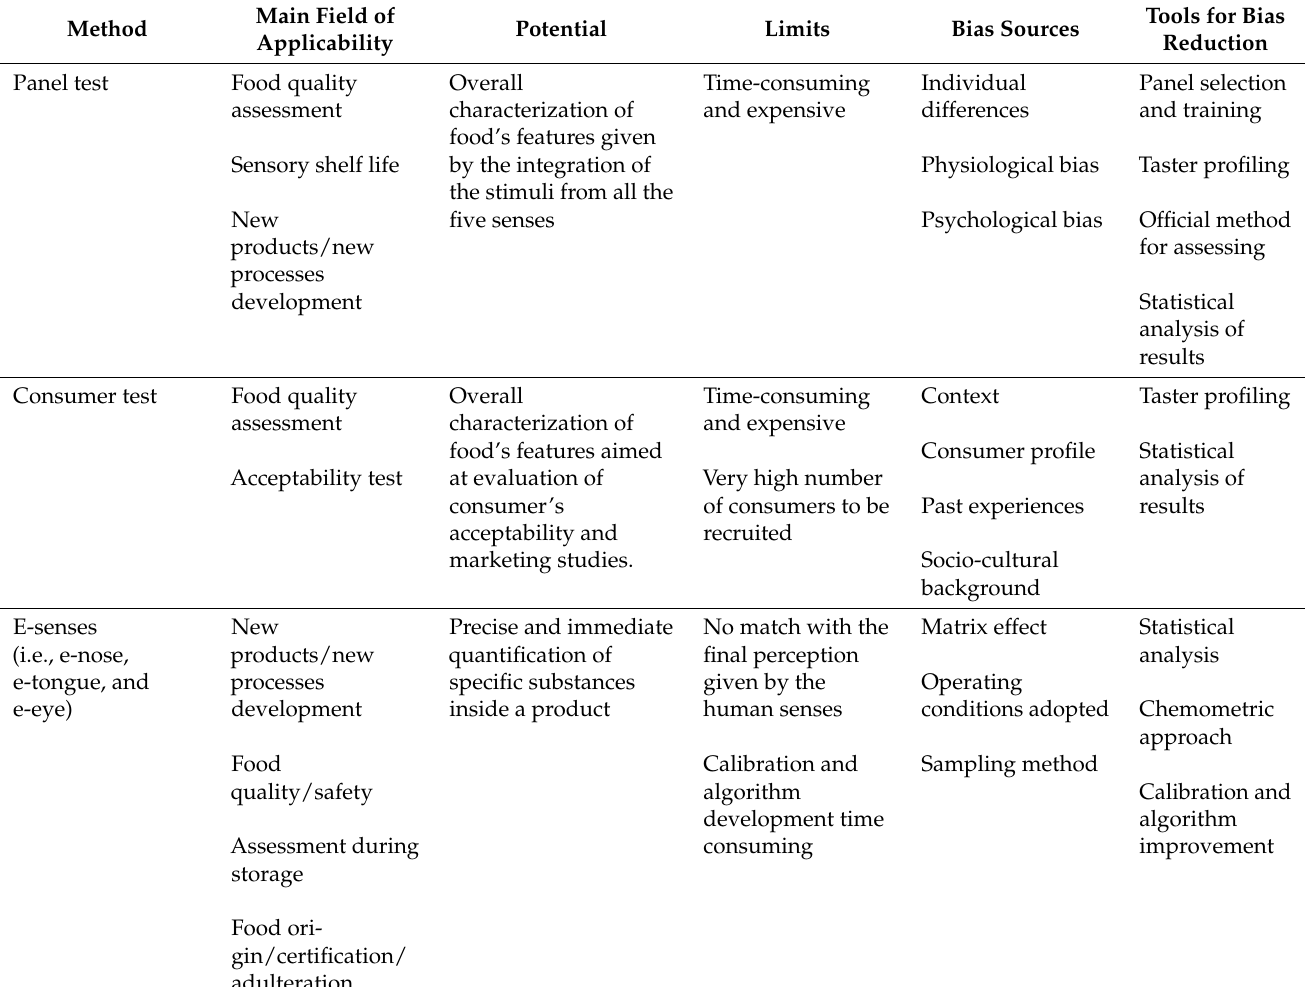
Table 4. Application, potential, and limits of the methods discussed in Sections 3 and